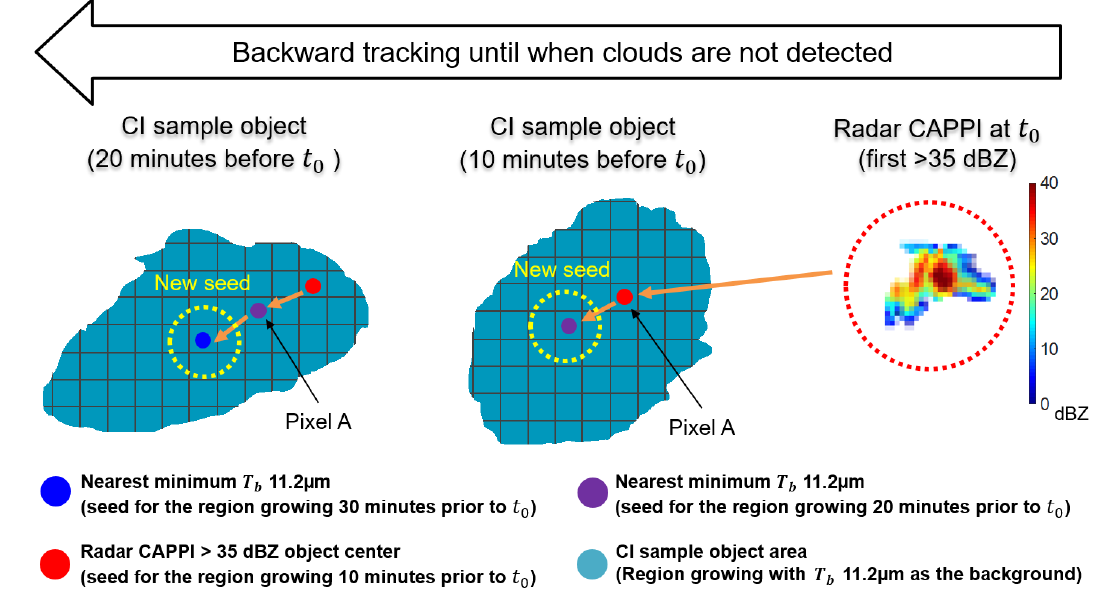
Figure 2. The process of the automated sampling tool. From the right to left side, the backward cloud object tracking was conducted using the region growing method. Starting with the seed points from radar constant altitude plan position indicator (CAPPI) echo ≥ 35dBZ area, seed points were updated iteratively. t 0 is the time when rain starts to fall.